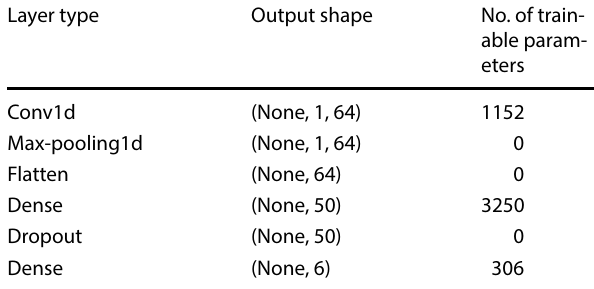
Table 6 CNN network